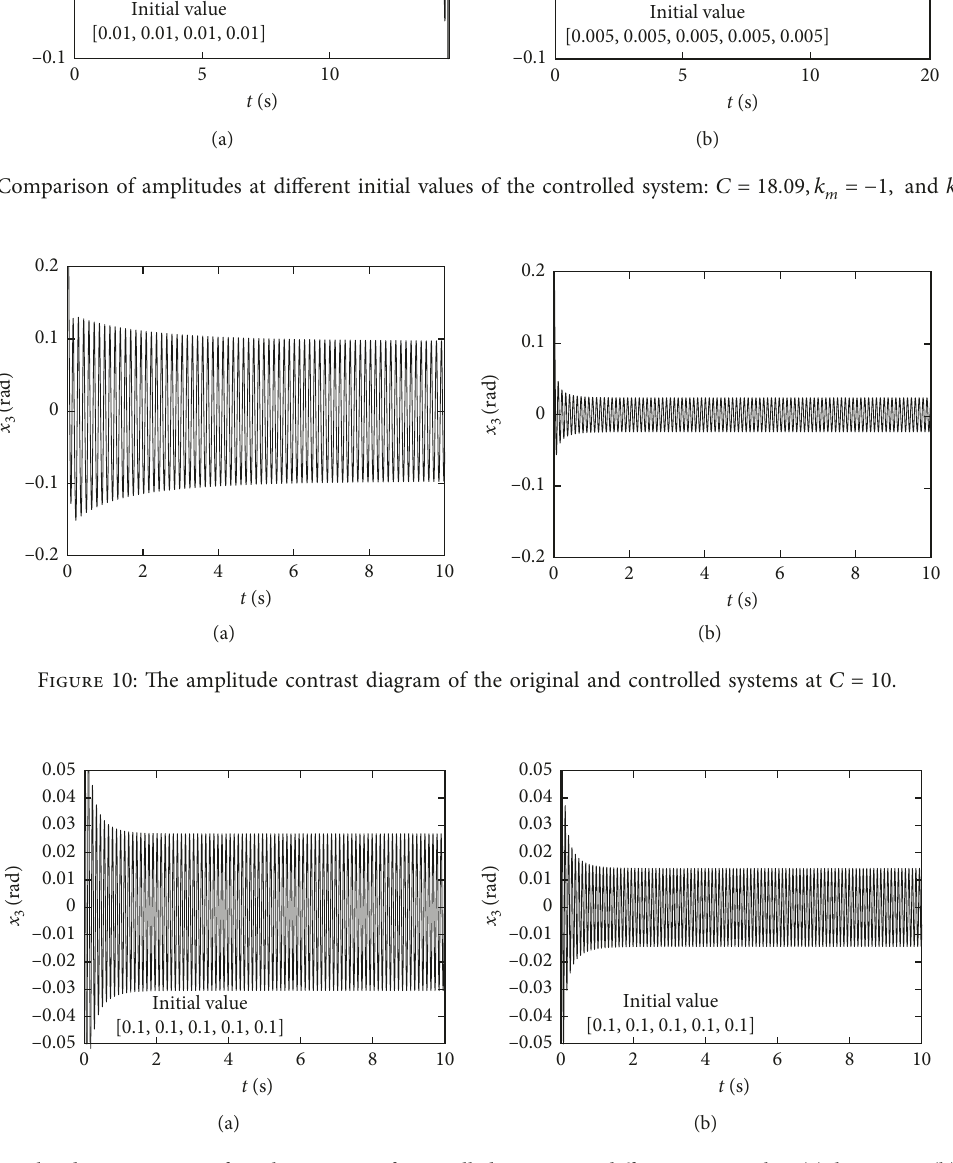
0 . 1; (b) k n n (cid:31) −